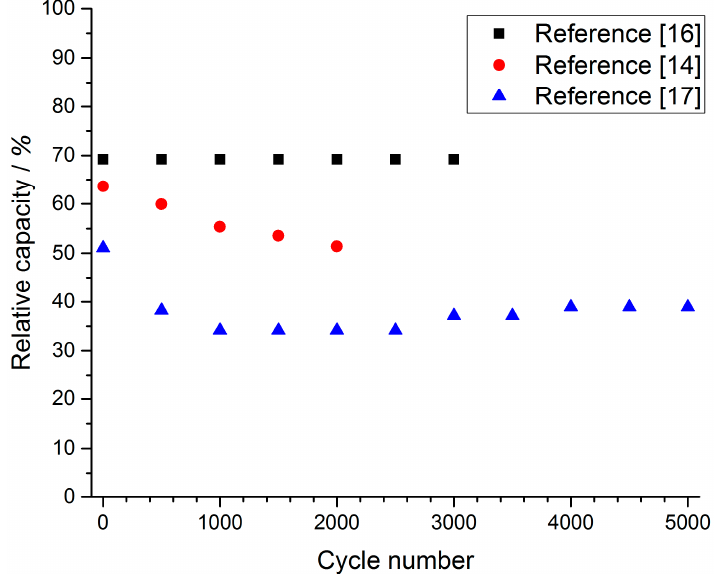
Figure 5. Evolution of the relative capacity of 3 different composite electrodes vs. cycle number cycled at 10 A·g − 1 rate [14,16,17].